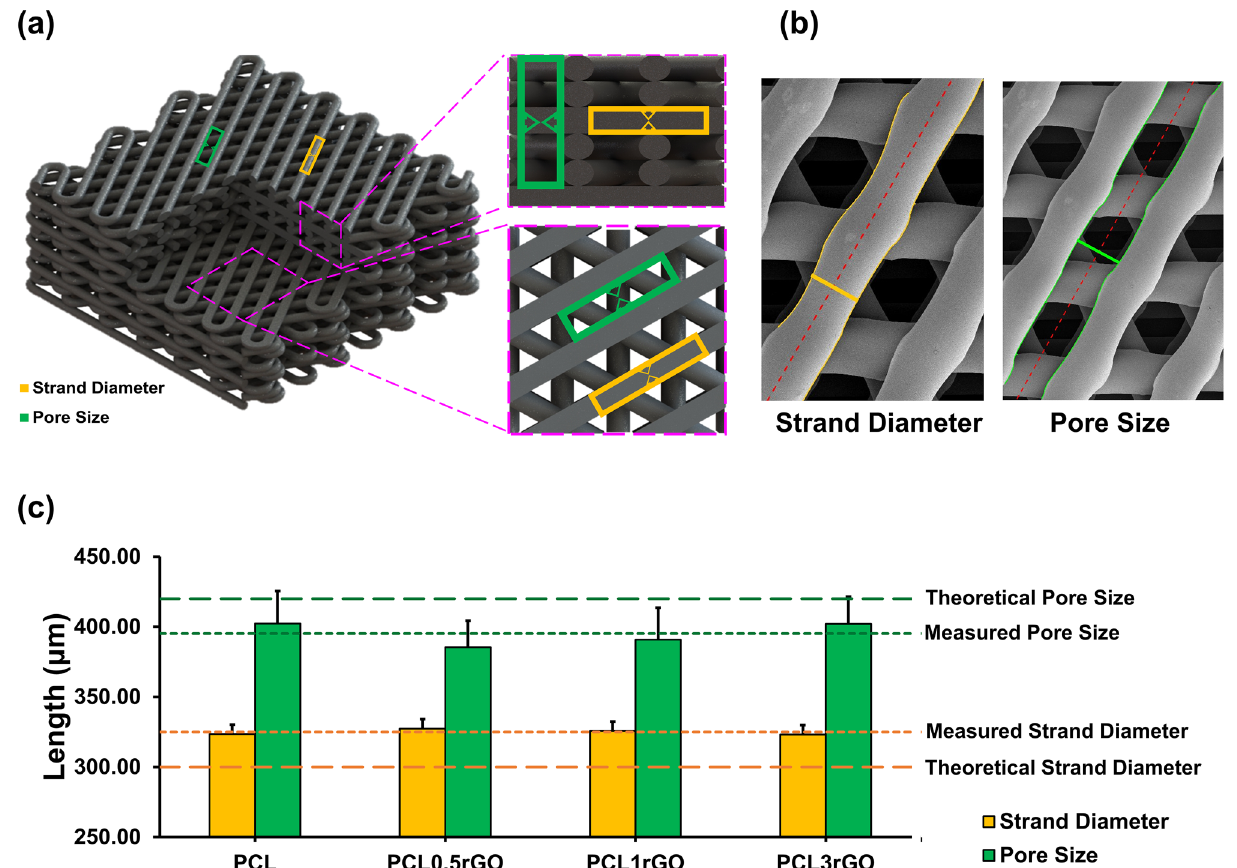
Figure 3. Dimensional characterization of the 3D printed PCL-rGO scaffolds. ( a ) A schematic of the 3D printed structures describing the structure pattern, strand diameter, and pore size from two fields of view. ( b ) A representative image of the measurement process in using the ImageJ macro code. The yellow lines represent the borders of the strands and the green lines represent the borders of the pore areas. The dashed red line indicates the average angle of each strand or pore area. The yellow or green perpendicular line is a representative line of the width that is measured specifying the strand diameter or pore size, respectively. ( c ) The measured strand diameters and pore sizes in comparison to their respective theoretical values. Results are presented as mean ±